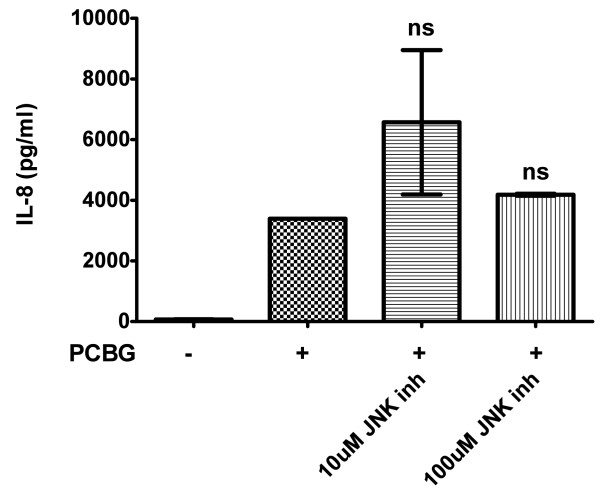
IL-8 production by PCBG activated cells is not impaired in the presence of a pharmacological inhibitor of JNK-II. 1HAEo- cells were incubated with 100 ug/ml of PCBG for a period of eight hours. Prior to the addition of PCBG, the cells were preincubated for one hour with JNK Inhibitor II at the concentration indicated. IL-8 secretion was measured by ELISA in the media supernatant of the cells. Data were analyzed with one-way ANOVA and posttest Bonferroni comparison (not significantly different, p > 0.05). The data shown is representative of two independent experiments.